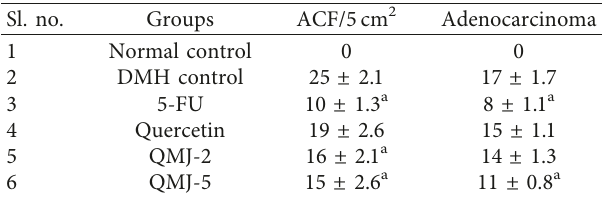
All values are expressed as mean ± SEM of six animals. a p < 0 . 05 vs. DMH control.